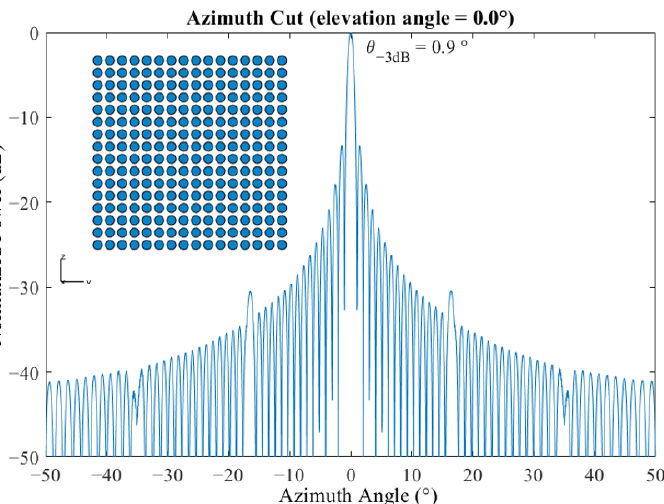
Figure 7. Azimuth cut of a 16 × 16 DRA, using subarrays as radiating elements separated by 2.5 λ 0